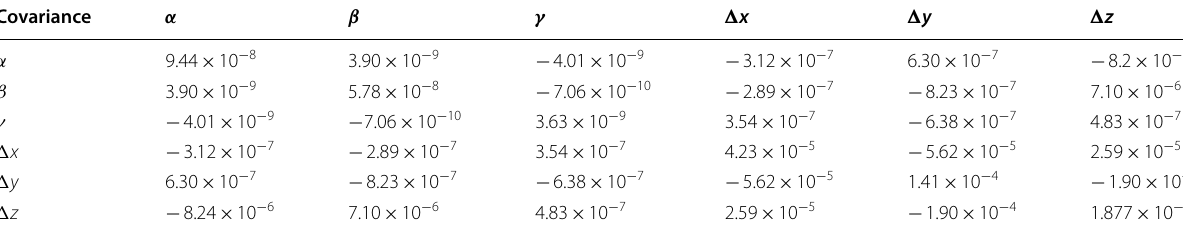
Table 3 Covariance matrix of α , β , γ , � x , � y , � z (mm 2 ) Covariance